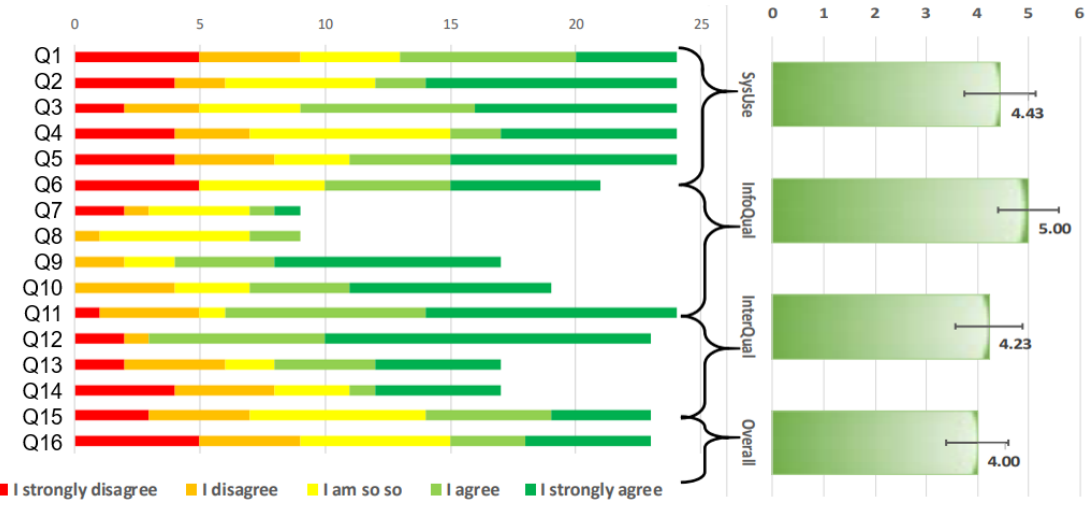
Figure 6. Results of the IBM